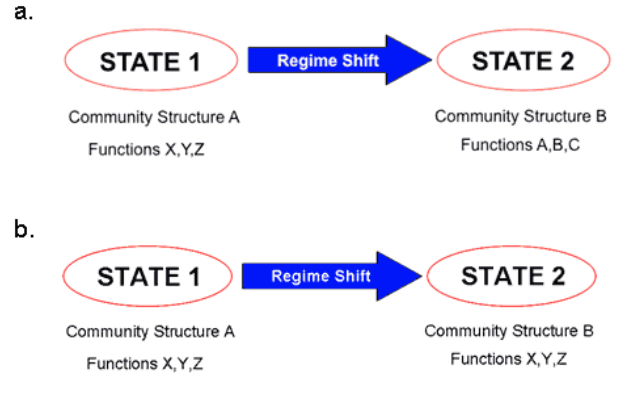
Fig. 2 . Relationships between community structure and function can be affected by environmental changes, such as climate. In some systems, a shift to an alternative state can yield community structure changes that lead to a shift in ecosystem functions (a), but guided transition aims to guide the shift in community structure in such a way that some desired ecosystem functions can be maintained through the transition